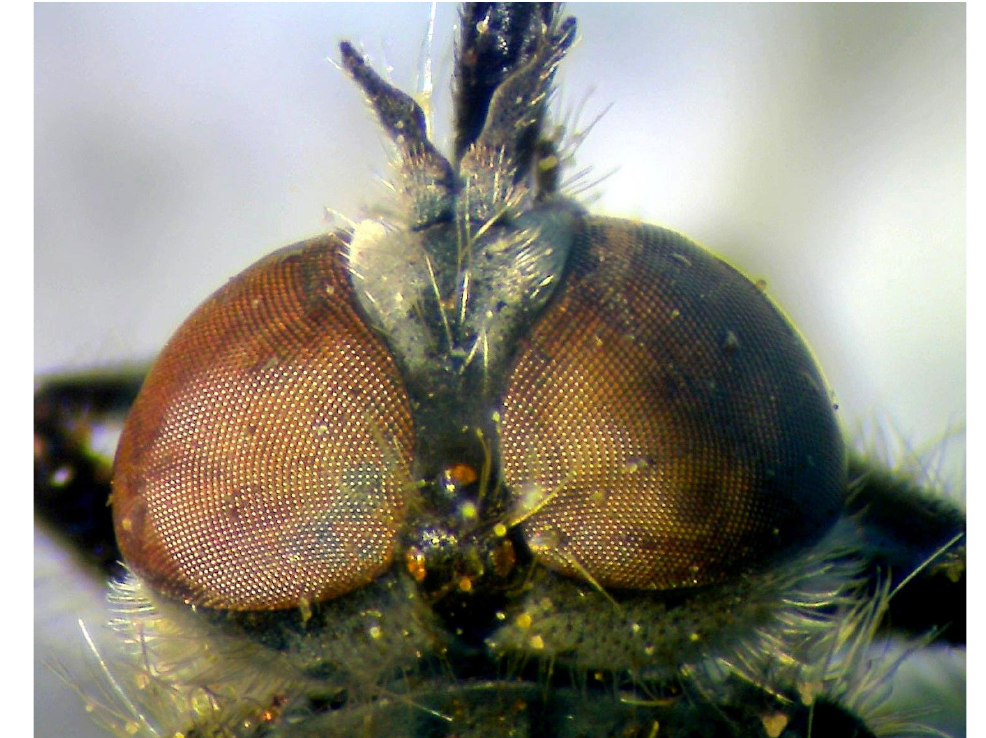
Fig. 21. Parusia aurata (Fabricius, 1794) gen. et comb. nov., ♂.